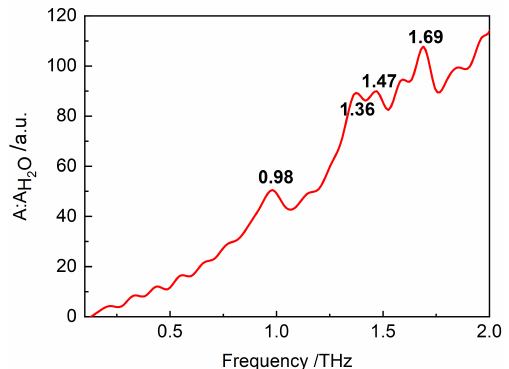
of the y -axis 2 O